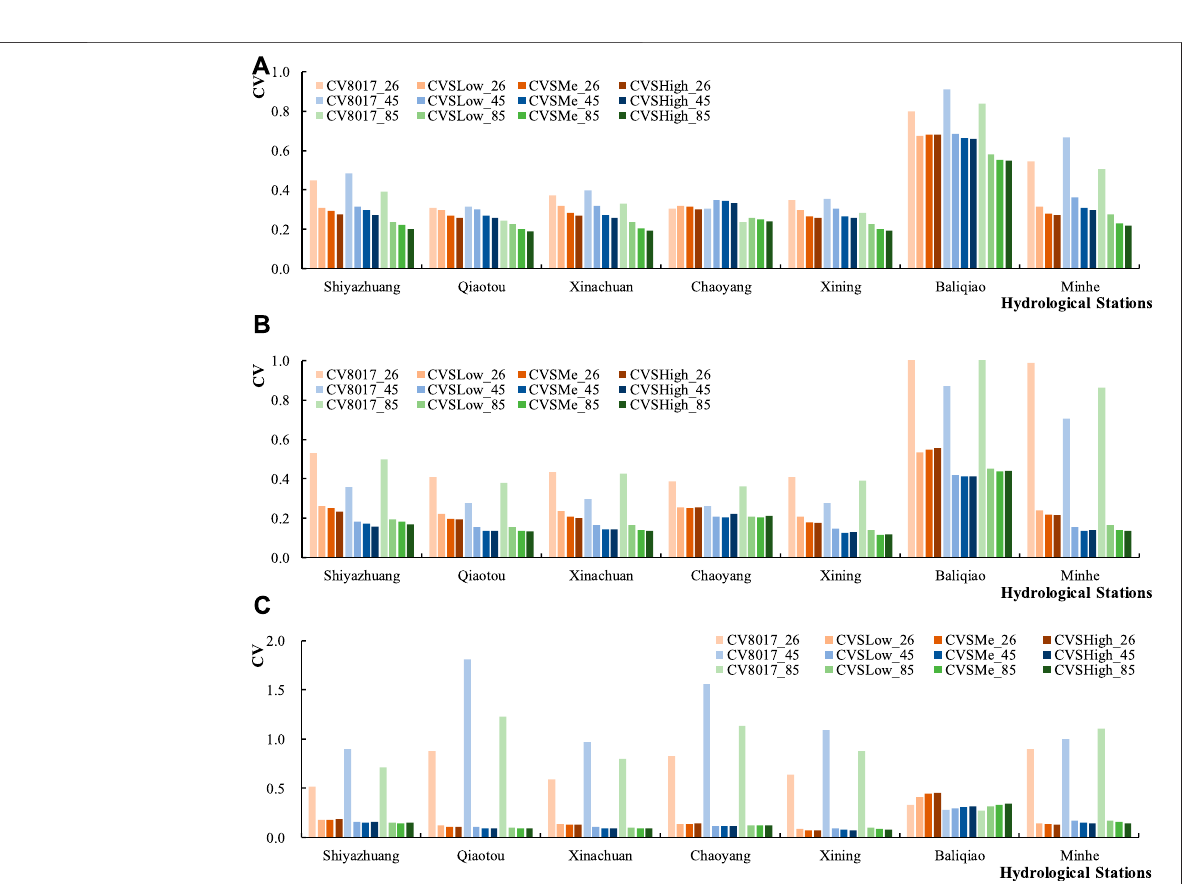
FIGURE 7 | The CV values of runoff in different hydrological periods under different layout schemes and different climate scenarios (A – C) represents the wet seasons, the normal seasons, and the dry seasons, respectively. CV8017_26/45/85 represents the variation coef fi cient of runoff in each hydrological period with the current slope ecological restoration under the emission scenariosof low-emission scenario (RCP2.6), medium-emission scenario (RCP4.5),and high-emission scenario (RCP8.5), respectively; CVSLow_26/45/85 represents the variation coef fi cient of runoff in each hydrological period with the layout schemes of slope ecological restoration at generally suitable grade under the emission scenarios of RCP2.6, RCP4.5, and RCP8.5; CVSMe_26/45/85 represents the variation coef fi cient of runoff in each hydrological period with the layout schemes of slope ecological restoration at moderately suitable grade under the emission scenarios of RCP2.6, RCP4.5, and RCP8.5; CVSHigh_26/45/85 represents the variation coef fi cient of runoff in each hydrological period with the layout schemes of slope ecological restoration at highly suitable grade under the emission scenarios of RCP2.6, RCP4.5, and RCP8.5, respectively.